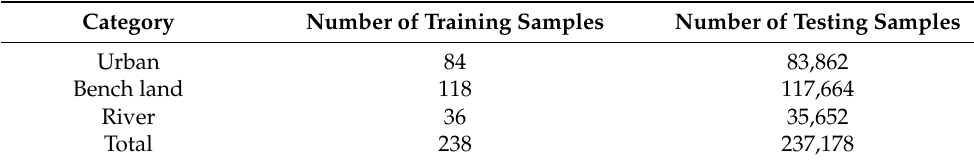
Table 7. The distribution of training samples in each category for the SVM in Xi’an area.